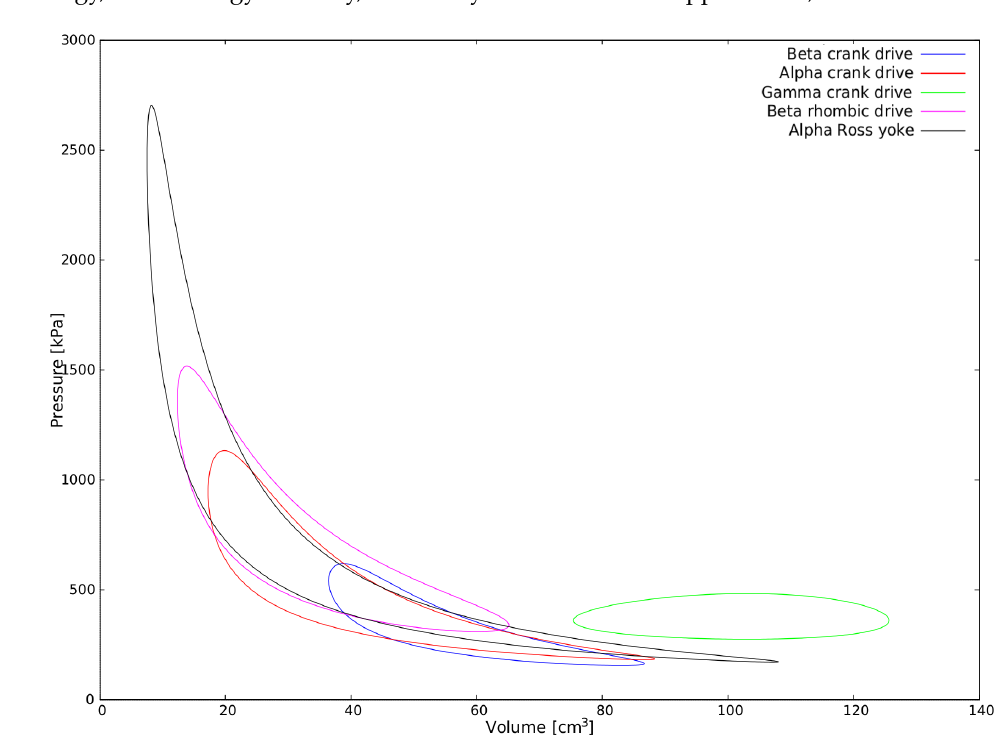
Figure 15. P-V diagrams